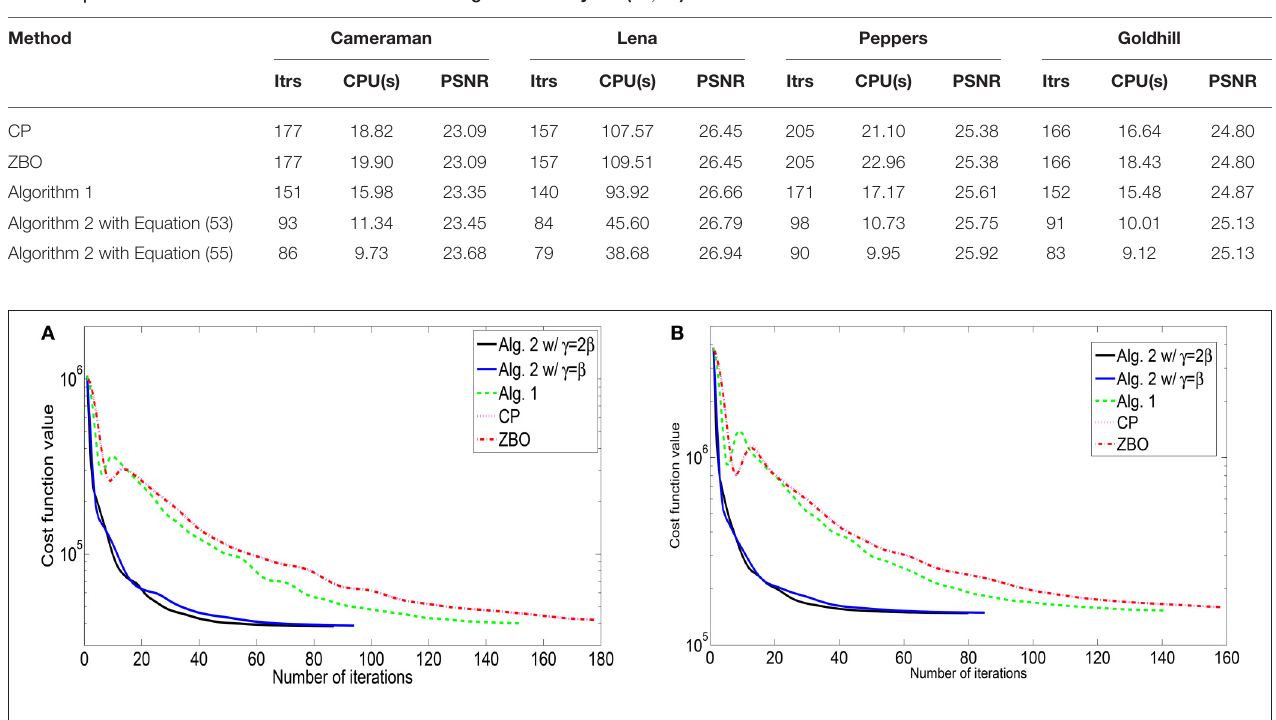
TABLE 2 | Numerical results for the L2-TV model for images blurred by the (15 , 10)-GBM. Method